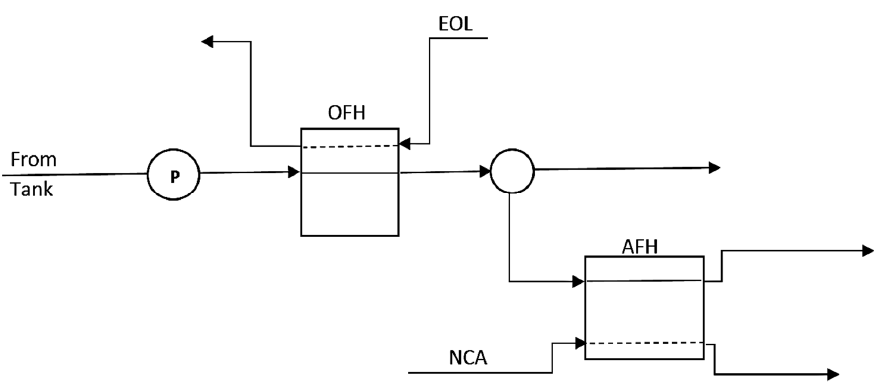
Figure 5. Thermal management system embodiments with two heat exchangers and recirculation path .